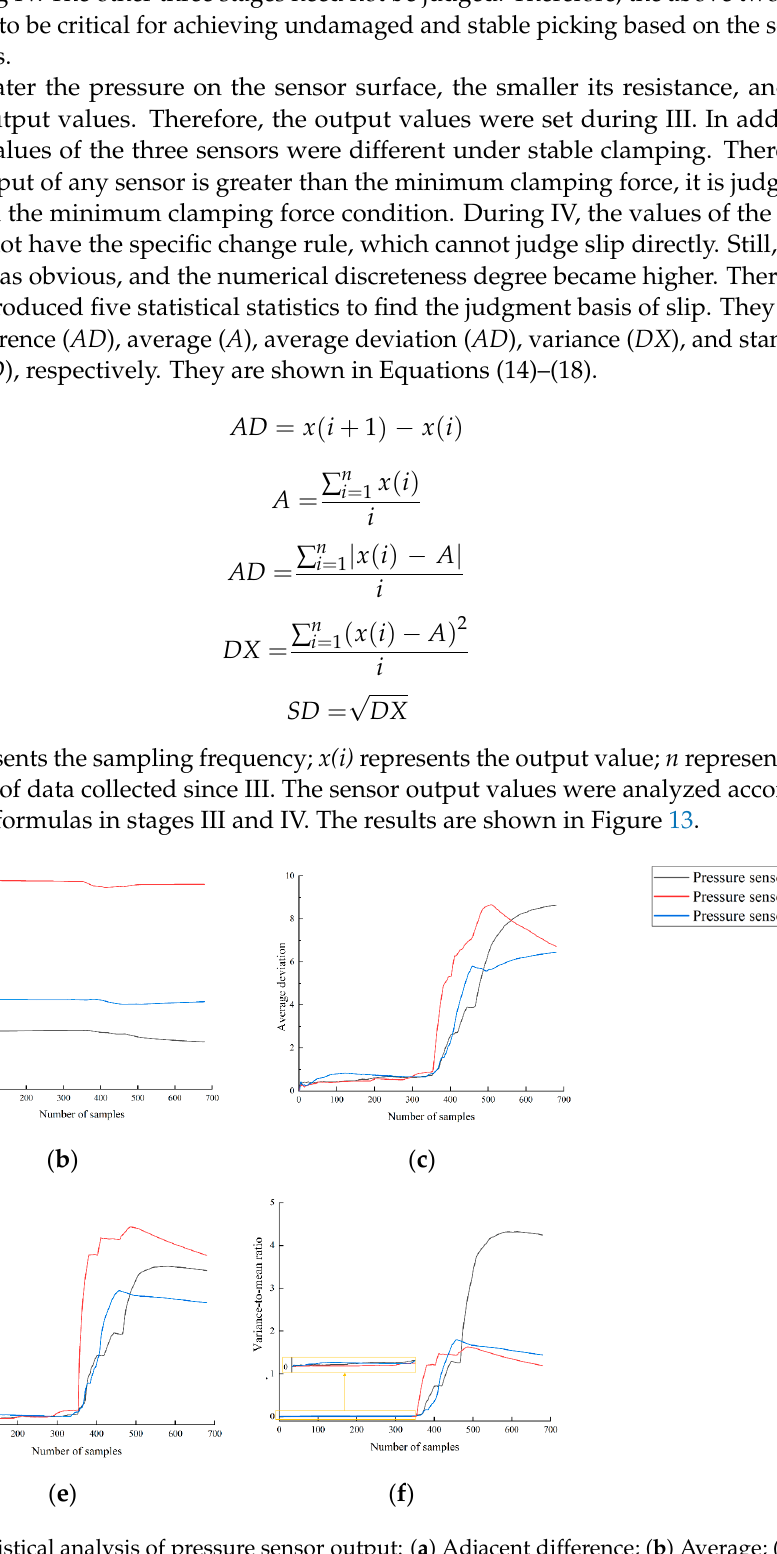
Figure 13. Statistical analysis of pressure sensor output: ( a ) Adjacent difference; ( b ) Average; ( c ) Average deviation; ( d ) Variance; ( e ) Standard deviation; ( f ) Variance-to-mean ratio.